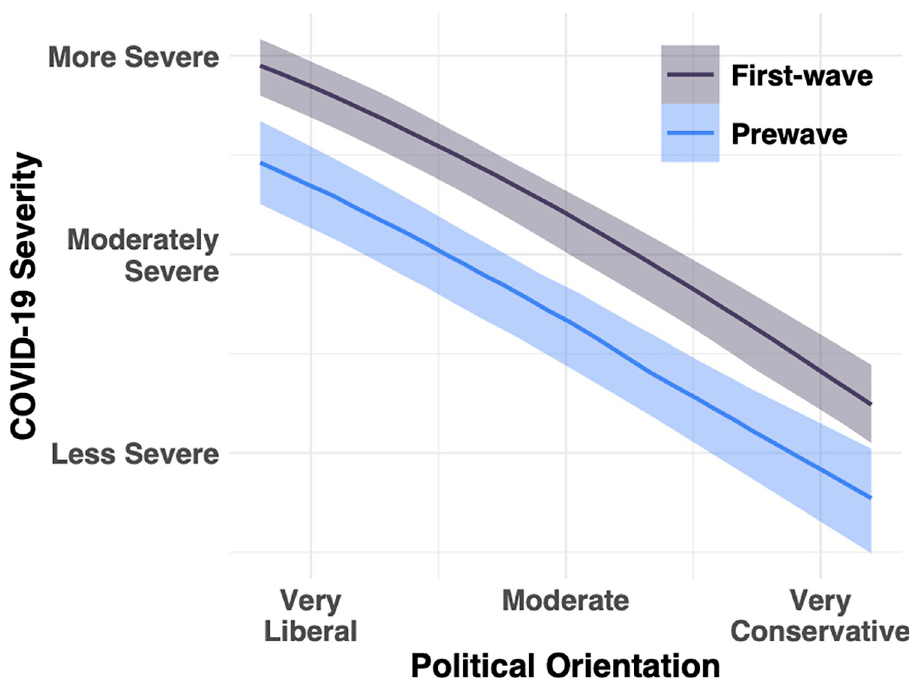
Fig 6. Shift in severity ratings from prewave to first-wave surveys as a function of political positions. Error bars = 95% credible intervals of effect of political beliefs on COVID-19 severity.